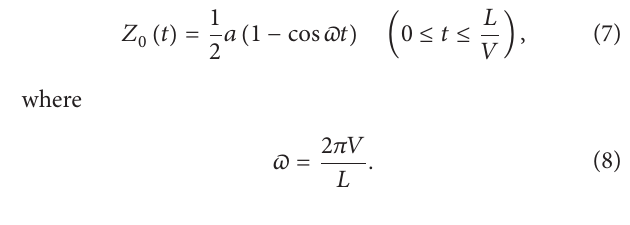
suspension in the vehicle, respectively, and 𝑔 denotes the gravity acceleration ( 𝑔 = 9.8 m/s 2